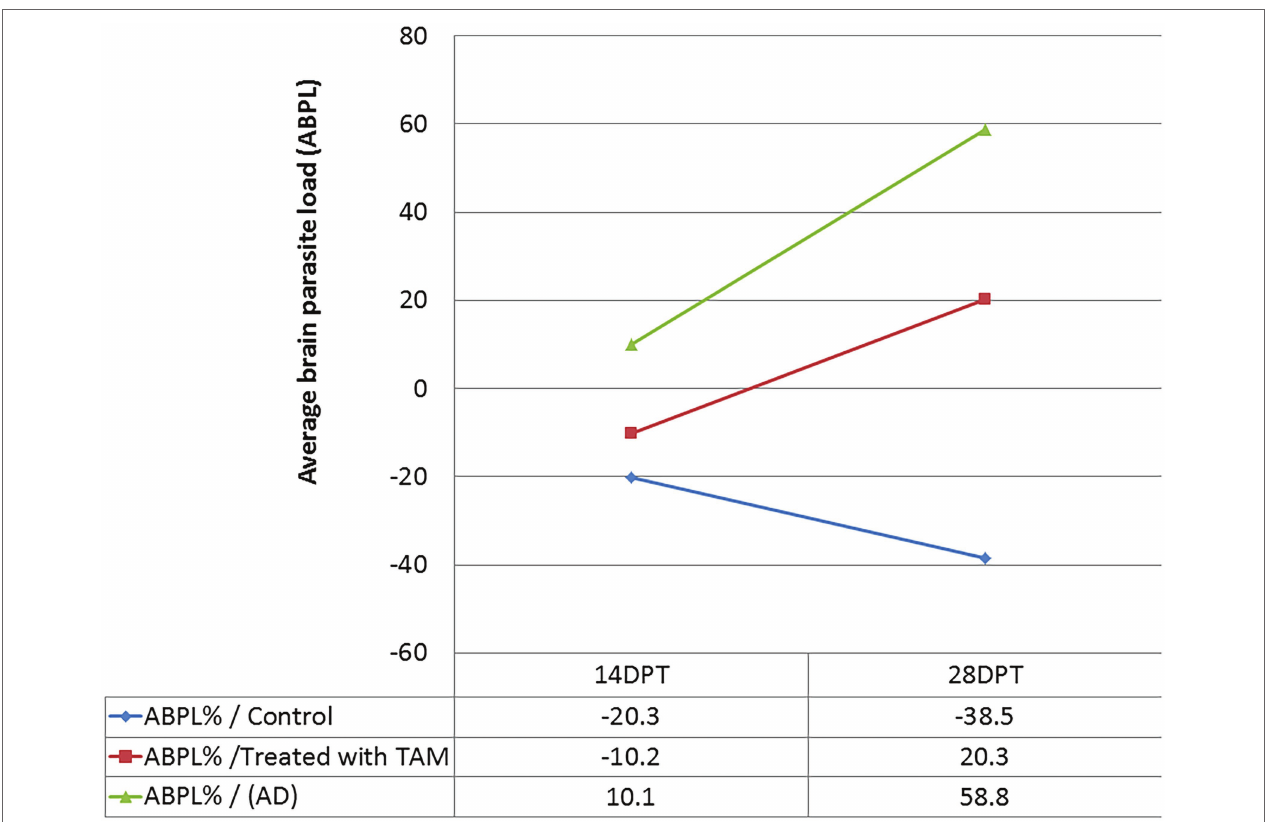
FIGURE 2 | Average brain parasite load (ABPL) of tamoxifen-treated animals as compared with control at different time points.